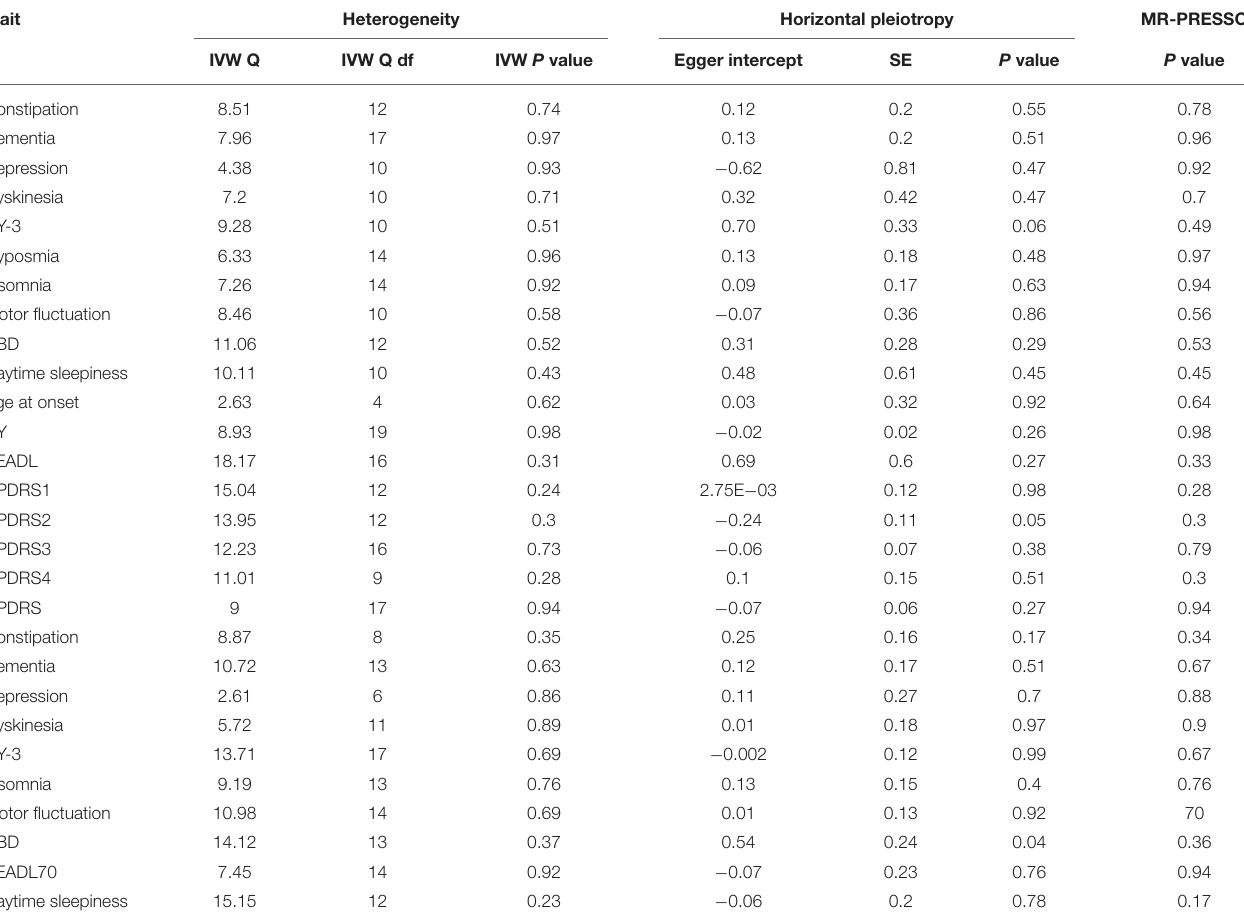
TABLE 1 | Heterogeneity and horizontal pleiotropy analyses between green tea intake and PD progression. Trait Heterogeneity Horizontal